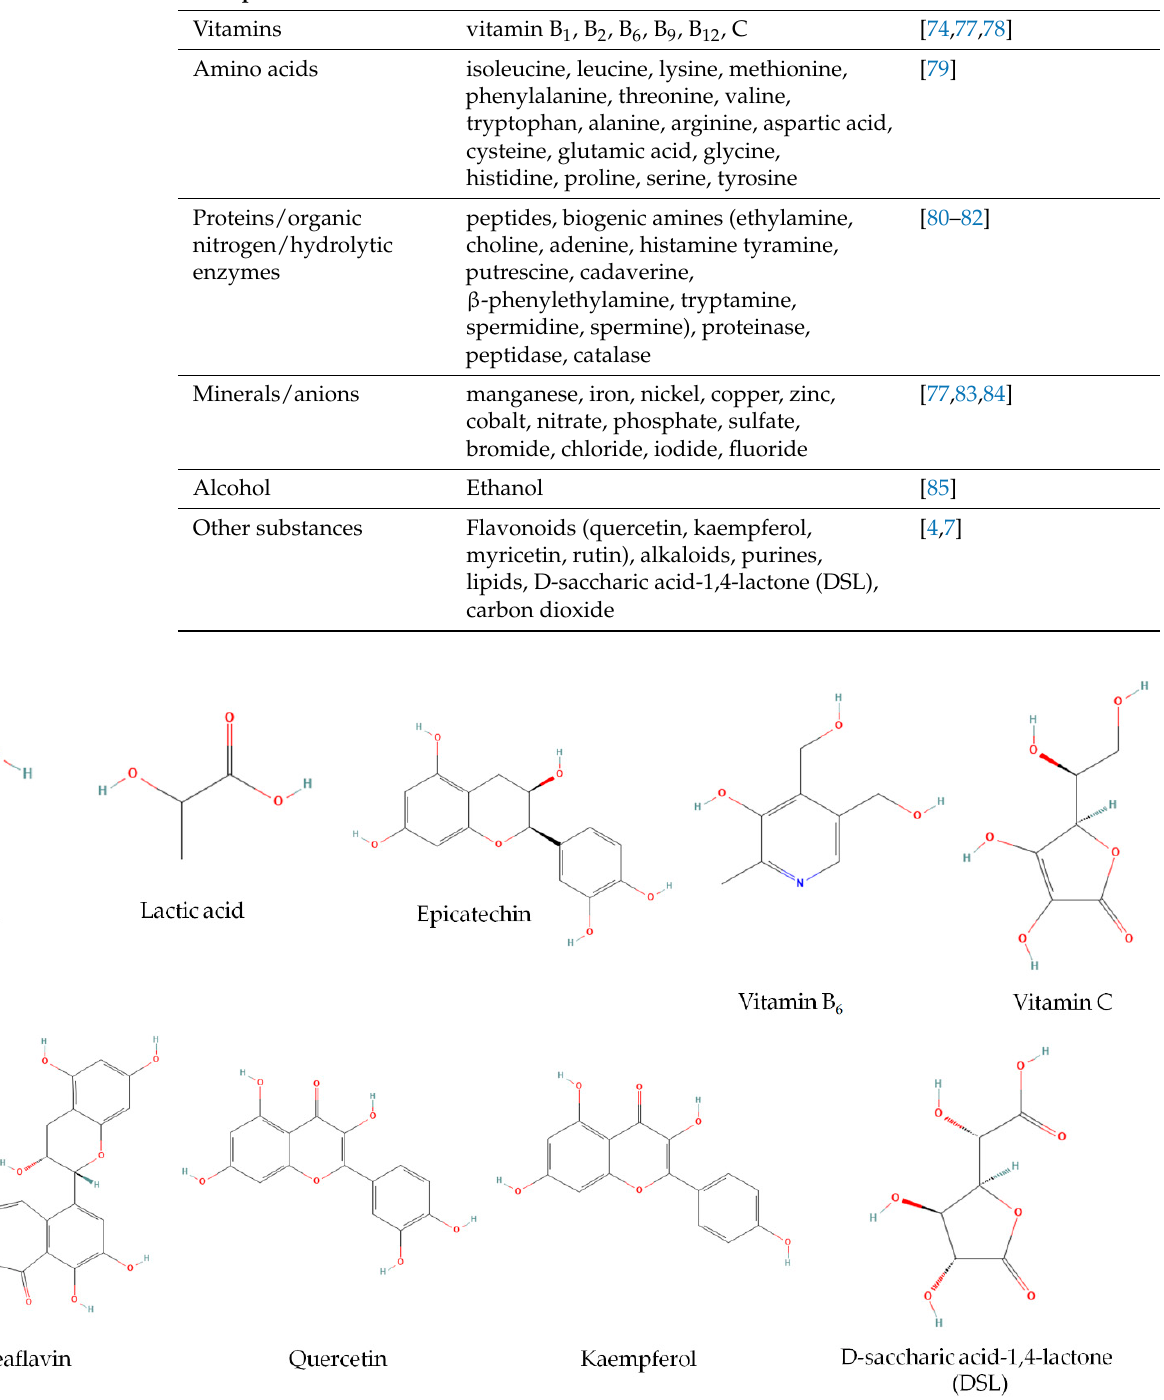
Figure 2. Chemical structures of some bioactive substances present in kombucha